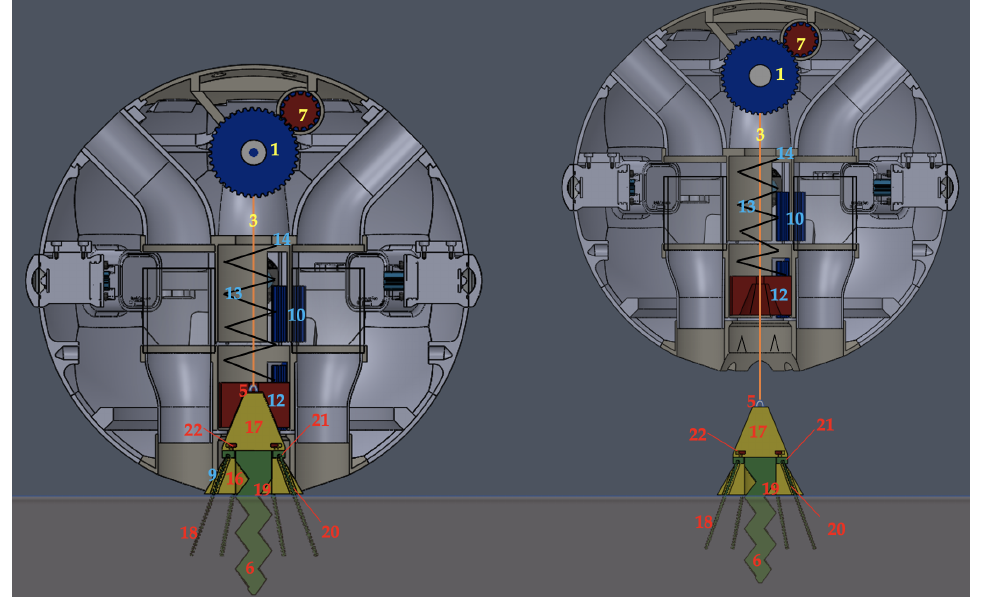
Figure 10. RAATM phase transition from rooted ( left ) to tethered ( right ) position.